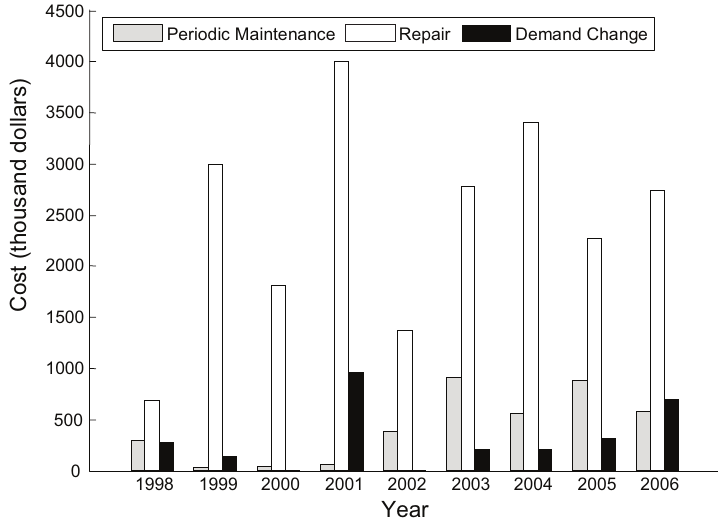
figure 2. Cost histogram of the West site